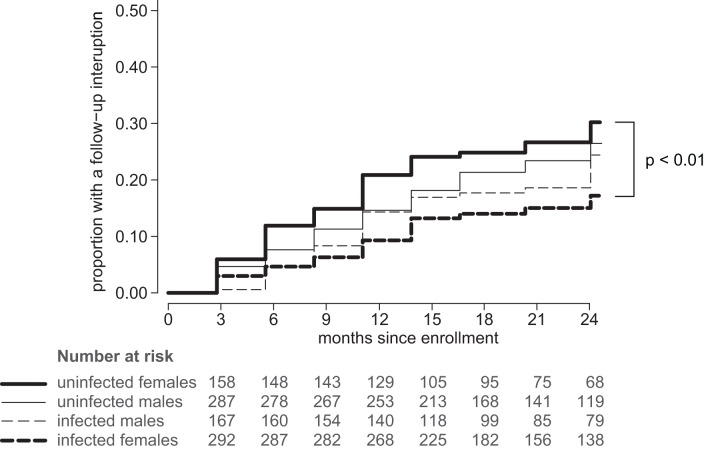
Cumulative incidence of follow-up interruptions.HIV-1-discordant couples were enrolled and followed quarterly for 2 years. A follow-up interruption (FUI) was defined as missing ≥2 consecutive study visits. The Kaplan Meier curves show the cumulative incidence of FUI separately for (—) HIV-1-uninfected females, (———), -infected females, (—) -uninfected males, and (– – –) -infected males.